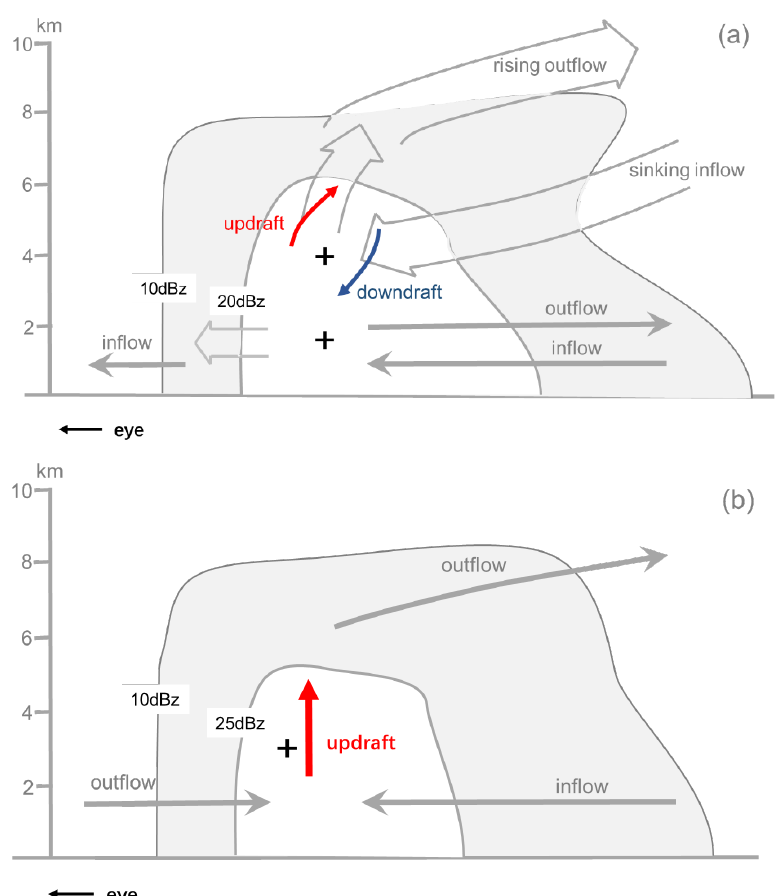
Figure 15. Schematic of the dynamics within the stratiform of outer rainband in Typhoon Higos, ( a ) the upwind of stratiform, ( b ) the downwind of stratiform. The broad arrows represent mesoscale secondary circulation. The gray line arrows represent vortex-scale motion associated with the overall storm. Red arrows mean updraft of vertical velocity. Blue arrow means downdraft of vertical velocity. Reflectivity contours are drawn. The plus signs indicate regions of increasing tangential velocity.